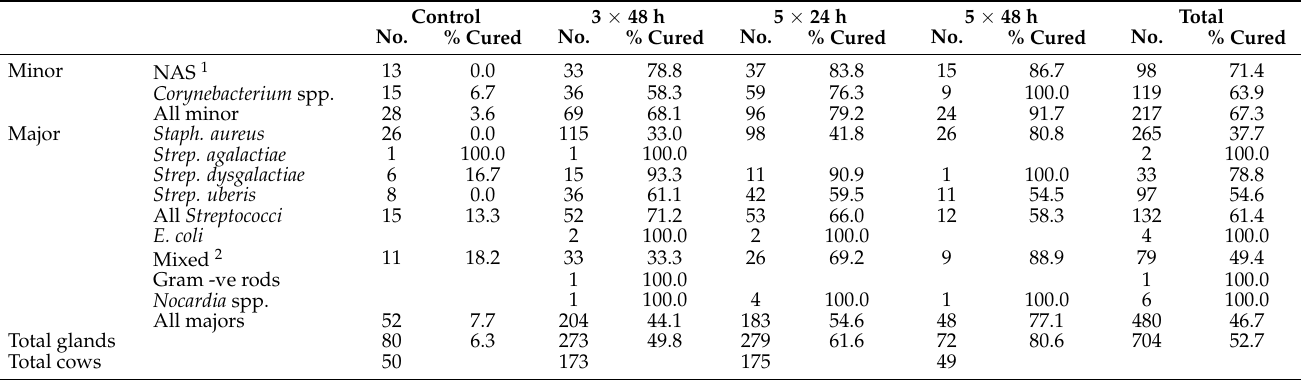
Table 1. Distribution (number of glands (No.)) of bacteriology results before treatment, and bac- teriological cure rate (%) by treatment group among bacteriological-positive glands treated with intramammary cloxacillin on 3 occasions at 48 h intervals (3 × 48 h), 5 times at 24 h intervals (5 × 24 h), or 5 times at 48 h intervals (5 × 48 h) or left as untreated controls following diagnosis with subclinical mastitis. The total number of glands and total number of cows are the number of glands and cows included in the final